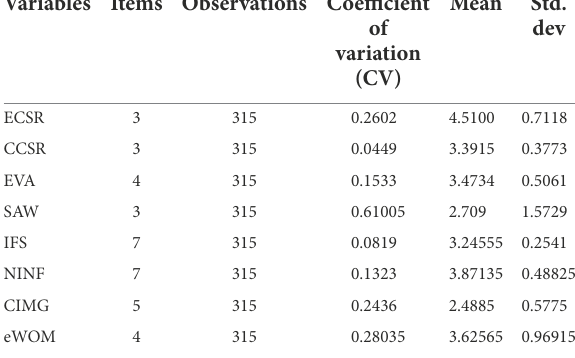
TABLE 3 The data’s descriptive statistics. Variables Items Observations Coefficient